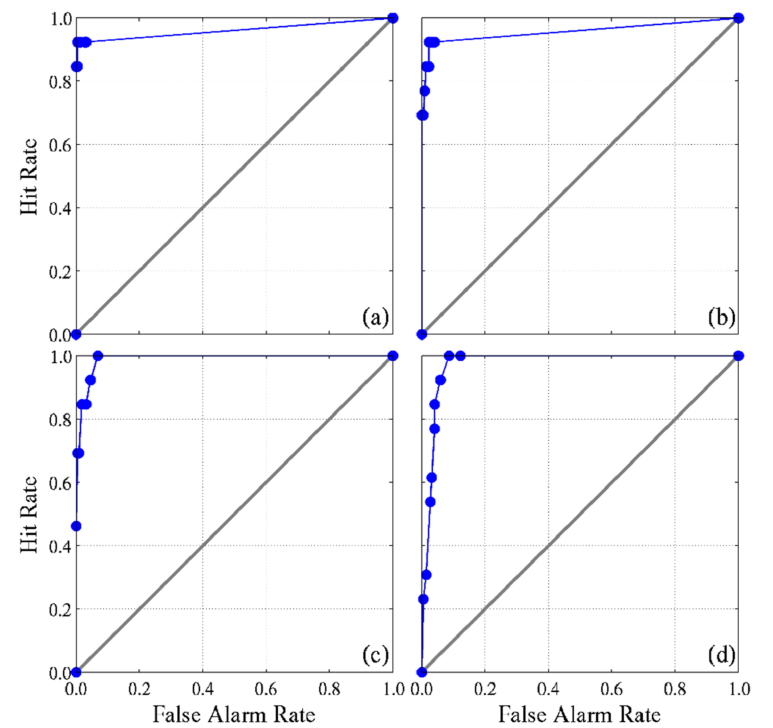
Figure 11. ROC with significant wave height of 4 m or above with forecasting lead times of ( a ) +00 h, ( b ) +24 h, ( c ) +48 h, and ( d ) +72